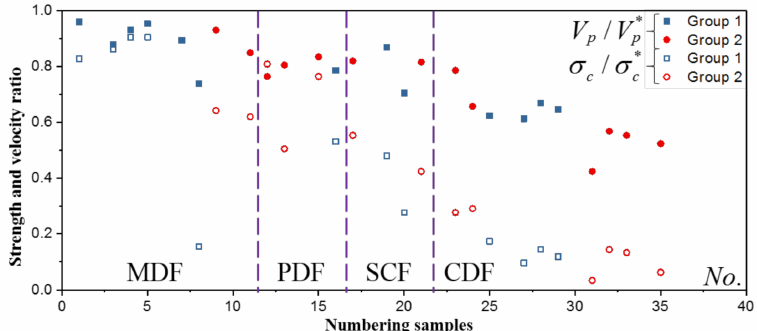
Figure 10. Distribution of longitudinal wave velocity ratio and strength